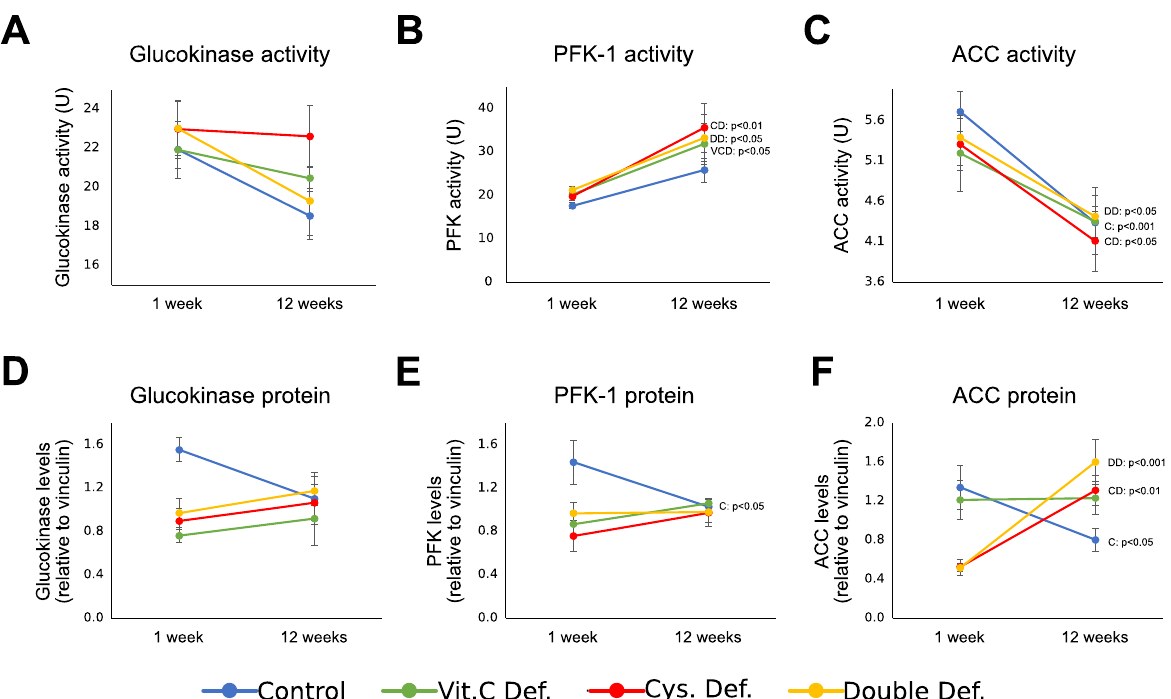
Figure 6. Developmental change of activity and protein levels of GCK, PFK, and ACC in liver of 1-week- and 12-week-old guinea pigs. ( A ). GCK activity did not significantly change with age in any of the groups. ( B ). PFK activity was not significantly increased in the control group with age, but it increased with age in all deficient groups. ( C ). ACC activity significantly decreased with age in control, cysteine deficient, and double deficient groups. ( D ). GCK protein level was not significantly affected by any of the neonatal deficiencies. ( E ). PFK protein levels decreased with age in control animals, but not in deficient groups. ( F ). ACC protein levels decreased with age in control animals, was not affected in the vitamin C deficiency group, and increased with age in both cysteine deficient animals. Mean ± SEM. C: Control group; VCD: